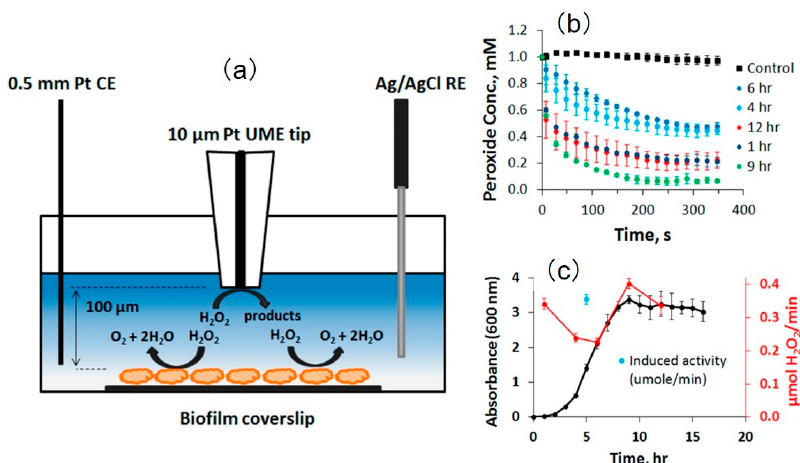
Figure 18. ( a ) Schematic of the electrochemical experimental setup for the SECM real-time measurement of hydrogen peroxide decomposition by a bacterial biofilm; ( b ) Hydrogen peroxide decomposition activity on V. fischeri CB37 biofilms at different incubation times; ( c ) Comparison of growth curve ( left axis, black line, and solid dots) for planktonic V. fischeri CB37 bacteria and hydrogen peroxide decomposition activity ( right axis, red line, and solid dots) on V. fischeri CB37 biofilms at designated incubation times. Copyright (2013) American Chemical